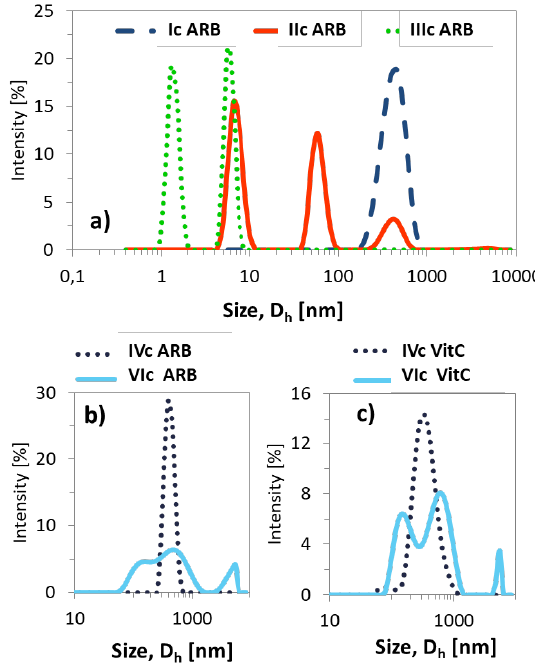
Figure 8. Size distribution plots by intensity for ARB- ( a,b ) or VitC ( c ) loaded polymer micelles in PBS at 25 °C.